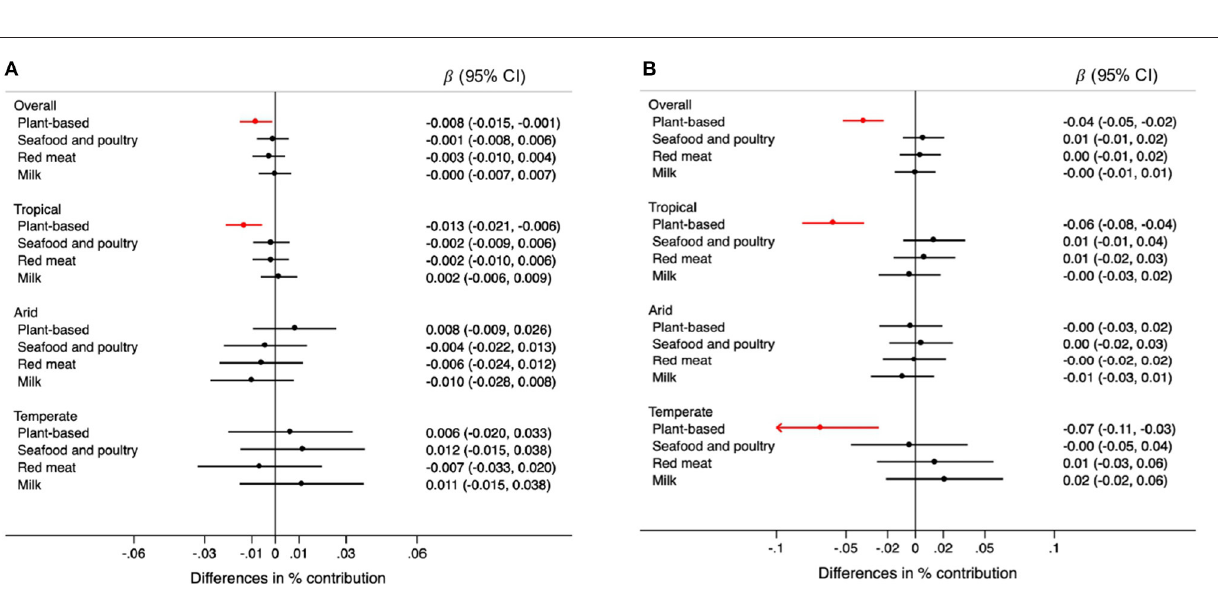
produced in Mexico are high-value export crops produced in irrigated lands